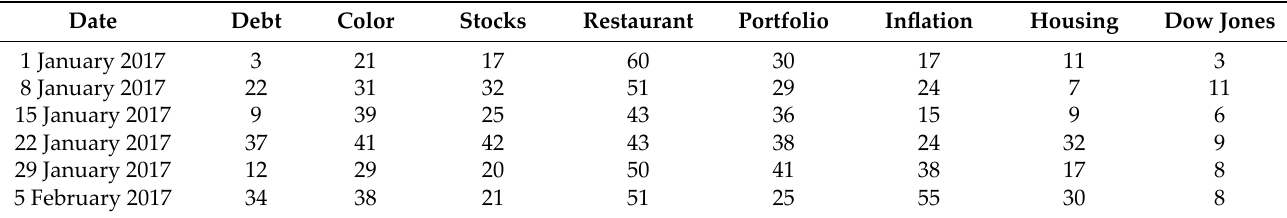
Table 3. Google Trends search terms for each word in Thailand.